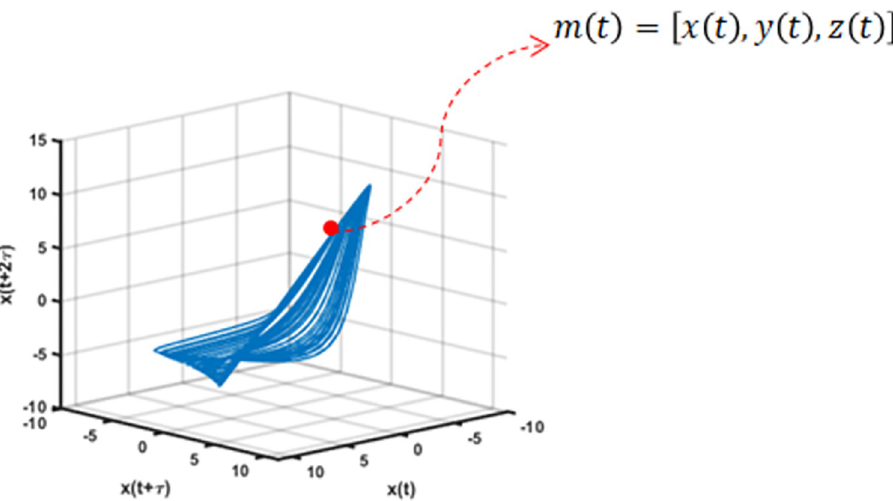
Fig 2. State space plot and sample